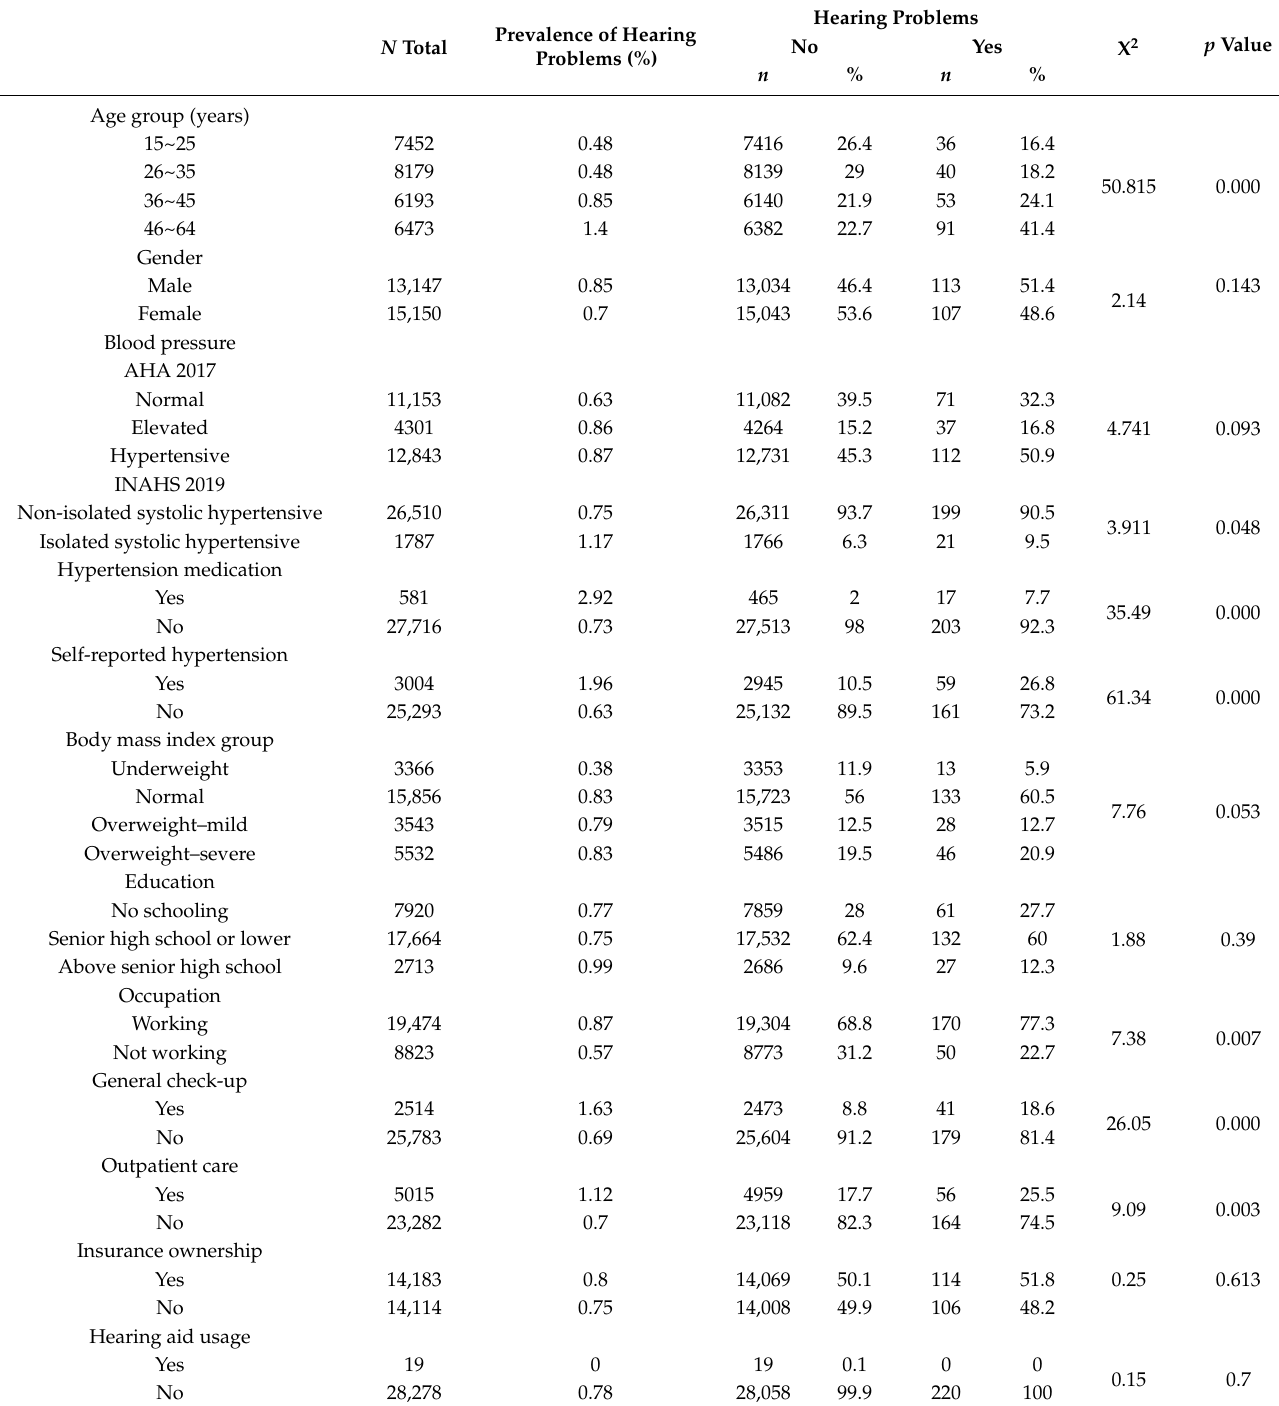
Table 1. Distributions of demographic data based on hearing